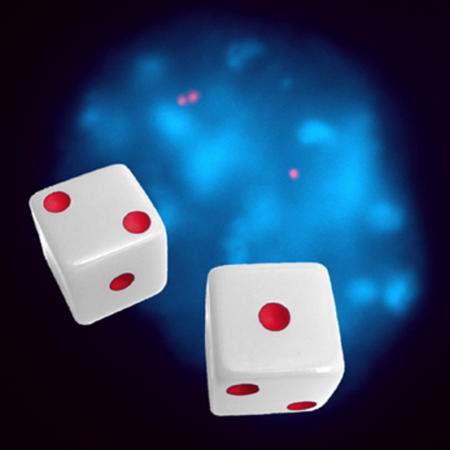
Chromosome-wide differences prior to X inactivation may underlie the random choice of which X chromosome will be silenced.